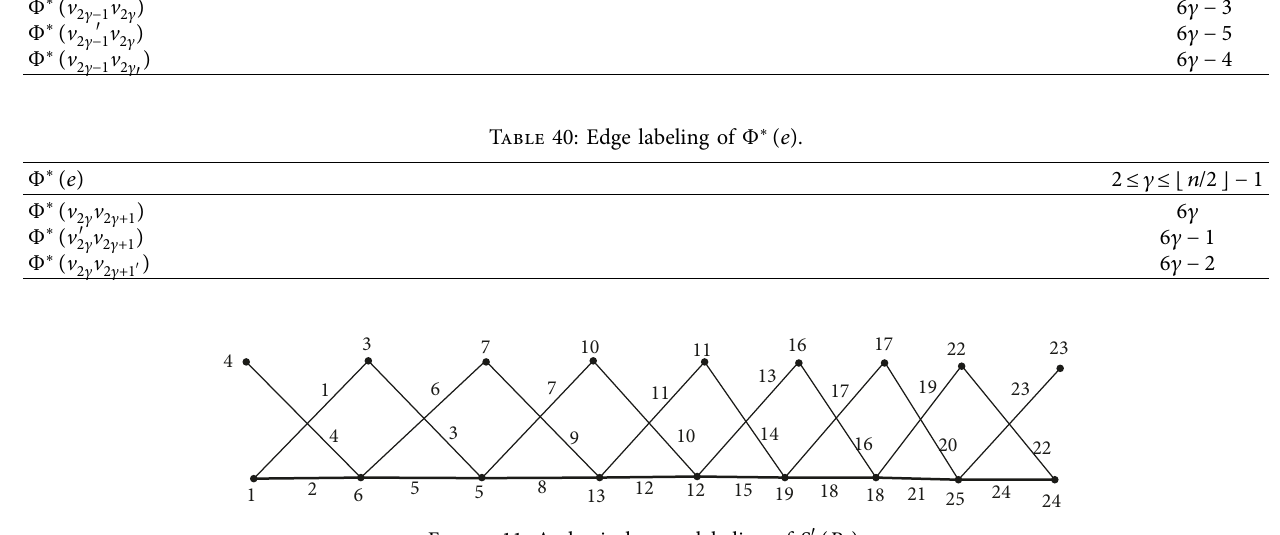
Figure 11: A classical mean labeling of S ′ ( P